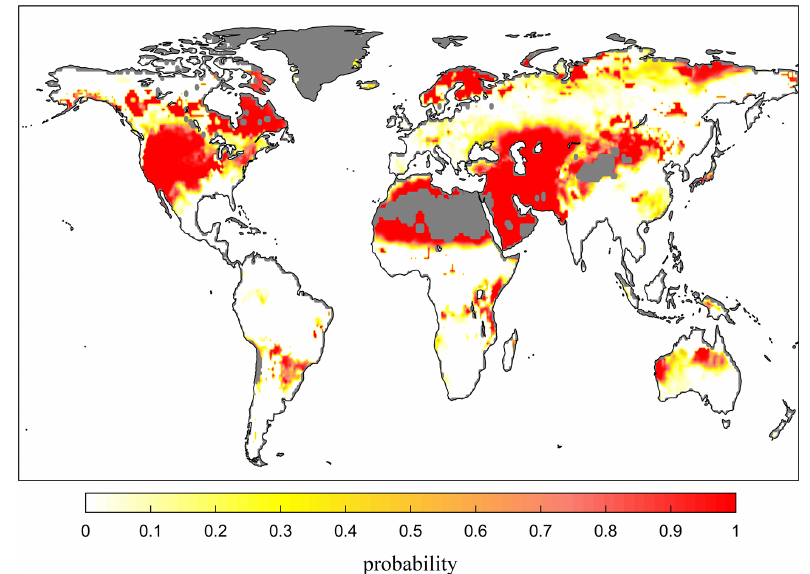
Figure 5. Global risk of flash drought occurrence. The risk is calculated from Eq. (7) as being the probability of soil moisture dropping from the 40th to the 20th percentile within 20d or fewer. Similar patterns can be found by using different